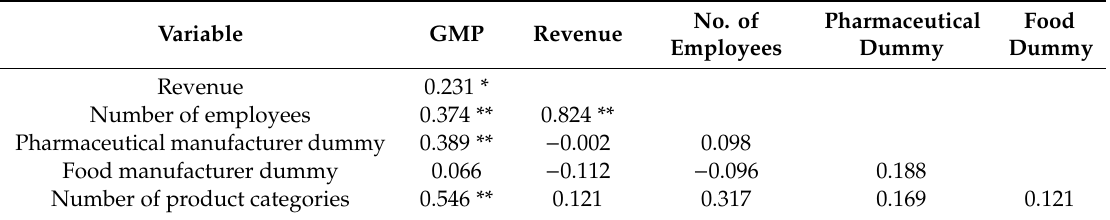
Table 2. Correlation coe ffi cients of selected variables (revenue size, possession of a license for manufacturing pharmaceutical products, and the number of categories of manufactured dietary supplement